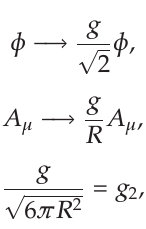
x (cid:2) − 3 , 3 , − 3 (cid:3) , where σ (cid:27) 1 1 δ y x Q I − 2 2